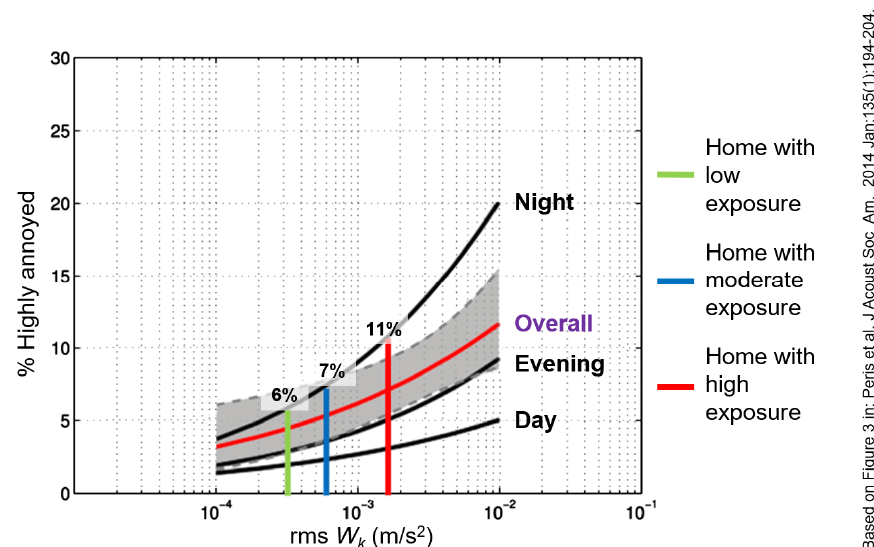
Figure A1. Comparison of the proportion of people reporting high annoyance (%HA) during the day, evening and night due to railway vibration (vertical vibration). Using the converted exposure data from the Graz immission survey (slow weighting).